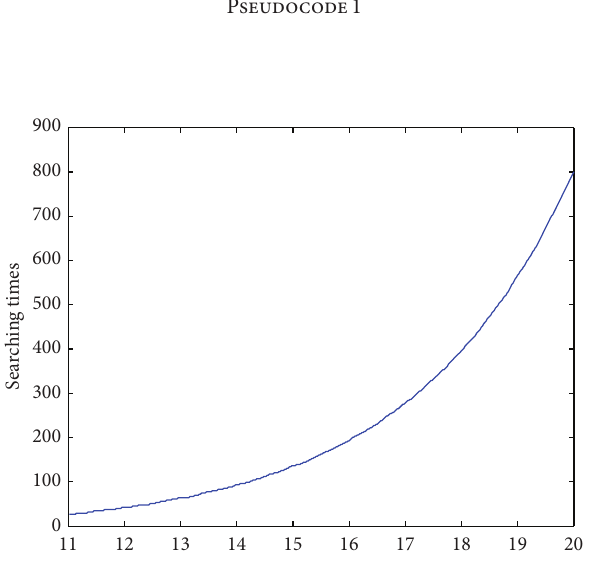
Figure 8: Relationship between Grover searching times and the number of quantum